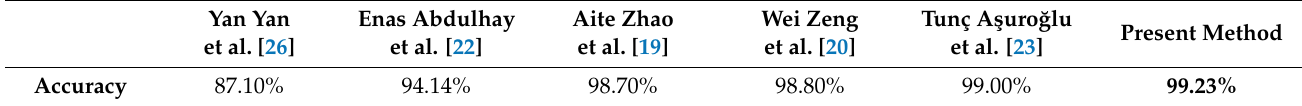
Table 8. Comparison with other